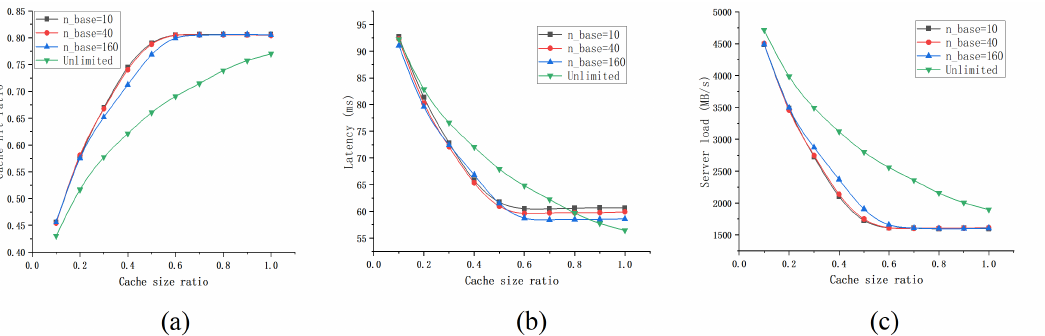
Figure 4. Performance of PB-NCC with different n base when the size of cache space changes. ( a ) the cache hit ratio under a different cache size ratio; ( b ) the average latency under a different cache size ratio; ( c ) the server load under a different cache size